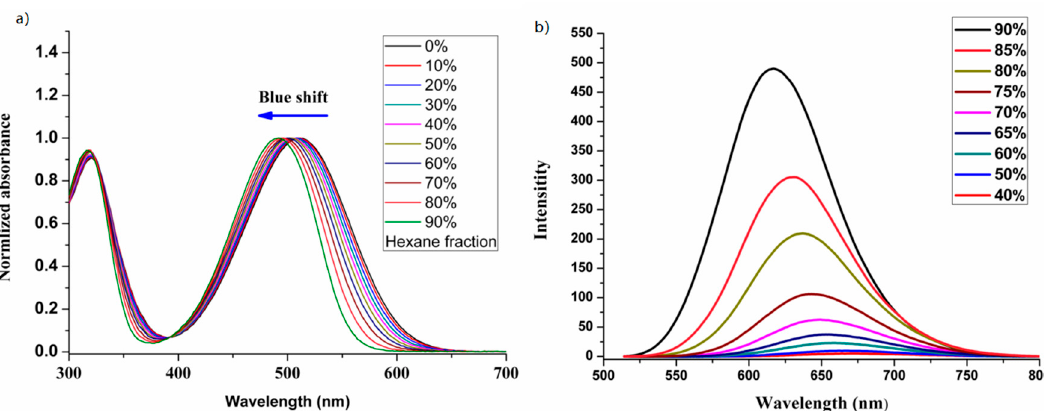
Figure 6. UV-Vis absorption spectra ( a ) and fluorescence emission spectra ( b ) of BTN with different ratios of tetrahydrofuran and n -hexane. Concentration: 2.0 × 10 − 5 M.